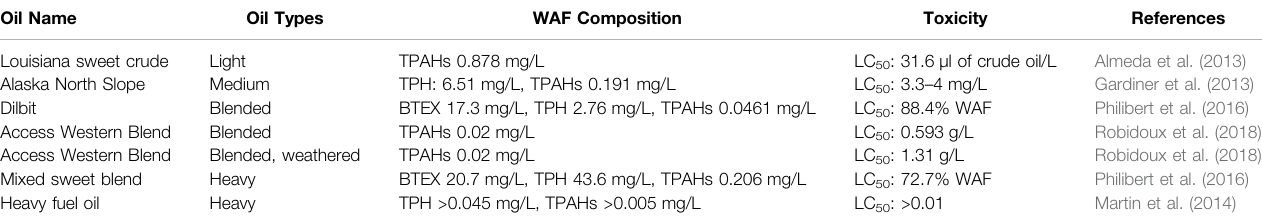
TABLE 1 | Toxicity of WAF prepared from different